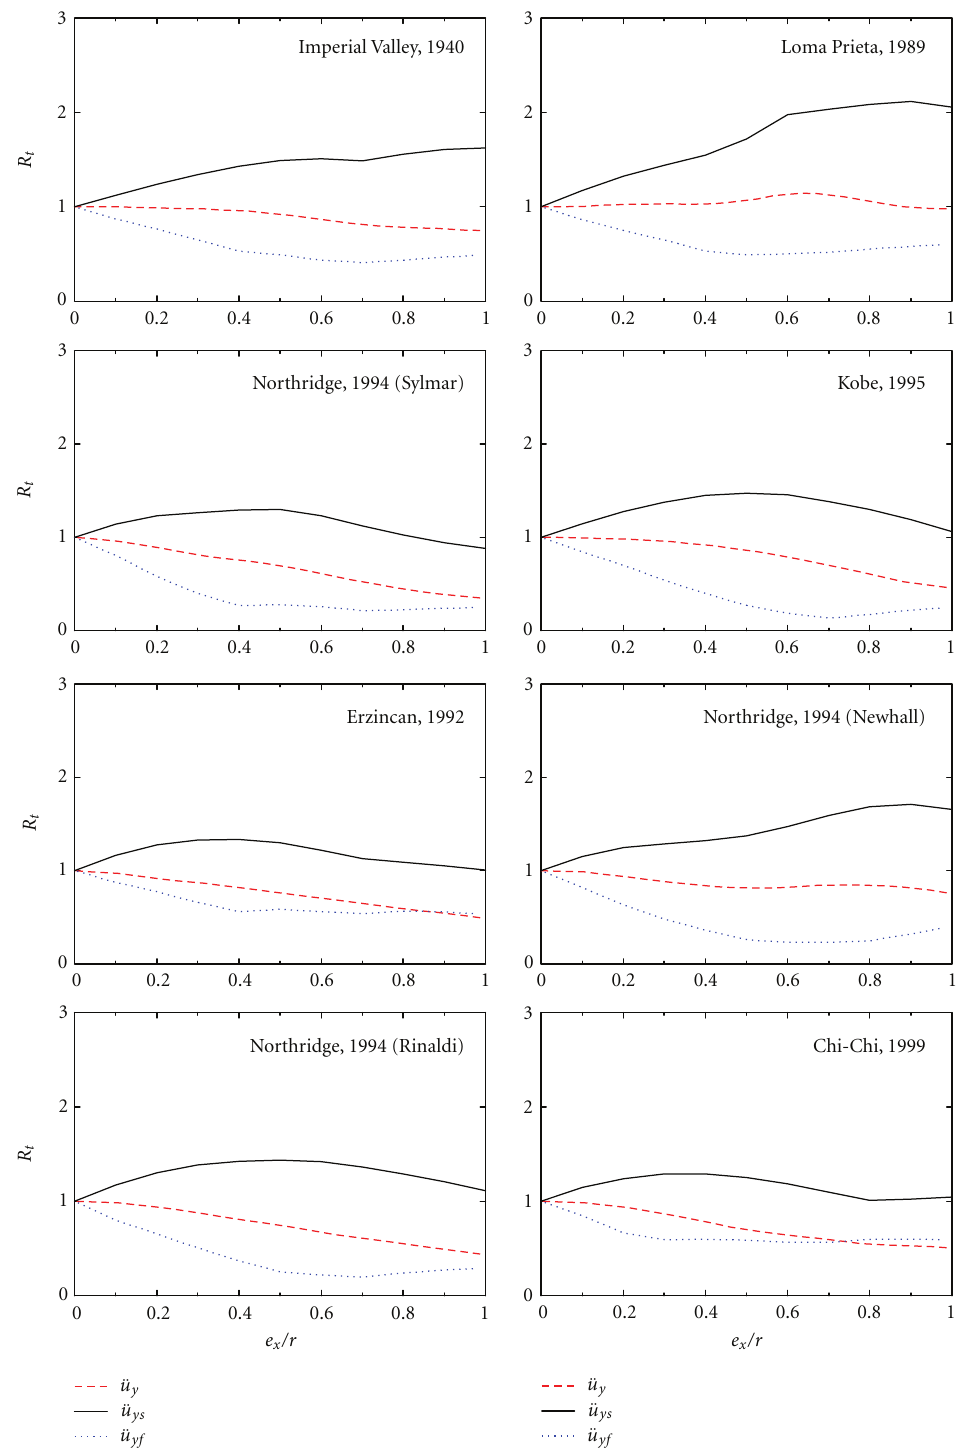
Figure 14: E ff ect of eccentricity on response ratio, R t for various peak accelerations ( T y = 1s, Ω θ = 0 .